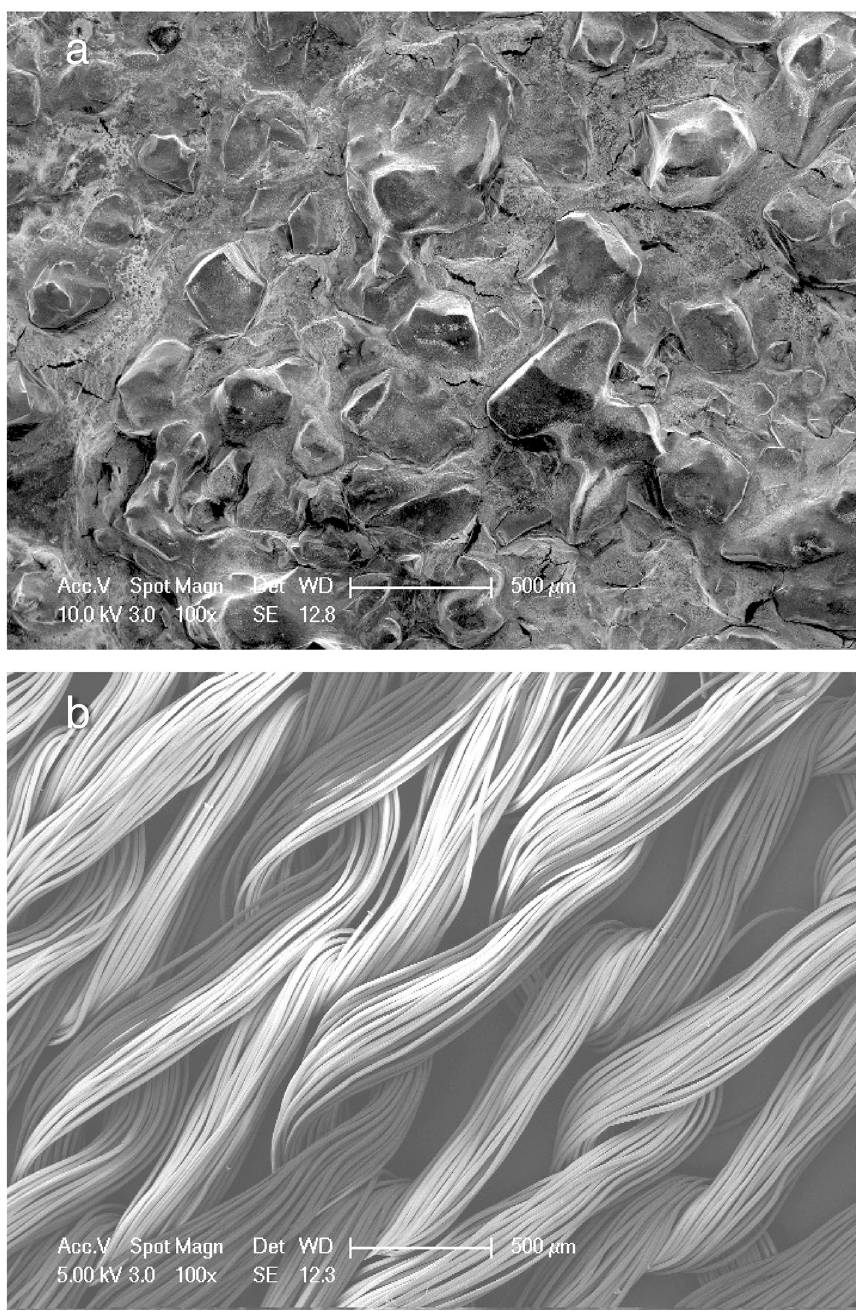
Figure 11. Scanning electron microscopy images of ( a ) FloSeal and ( b )